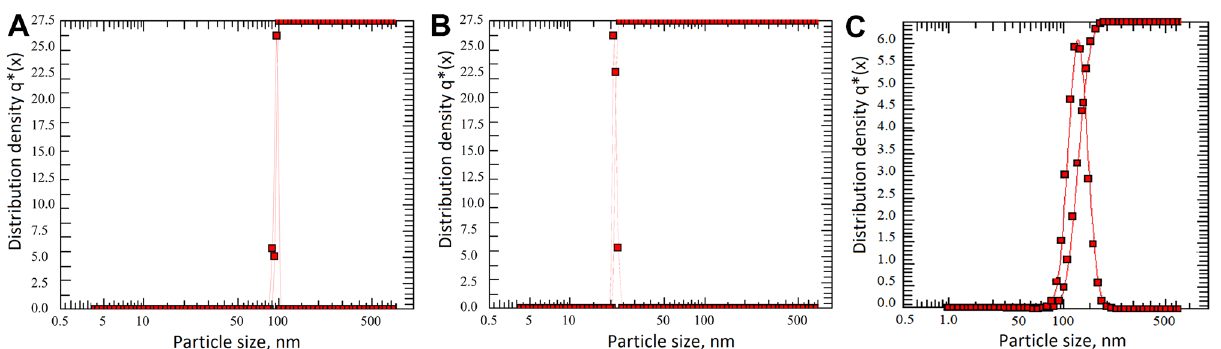
Figure 6. PCCS analysis: particle number distribution of synthesized AgNP-W ( A ), AgNP-F ( B ) and AgNP-S ( C ).